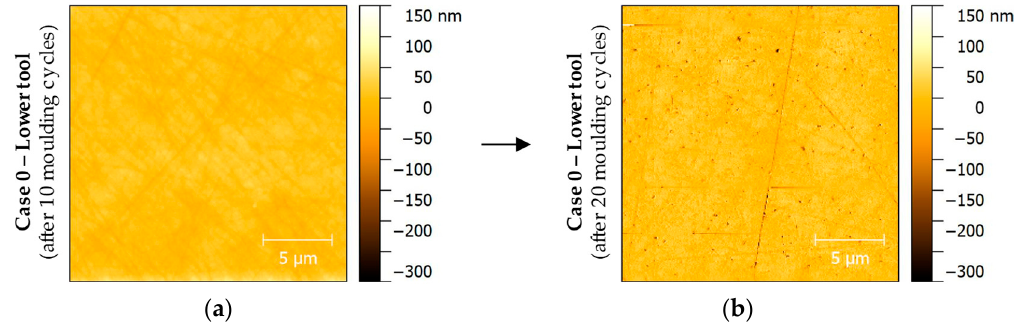
Figure 12. Atomic force microscope (AFM) measurements of Glassy Carbon mould tool surfaces of Case 0: ( a ) Lower tool after 10 moulding cycles; ( b ) Lower moulding tool after 20 moulding cycles.